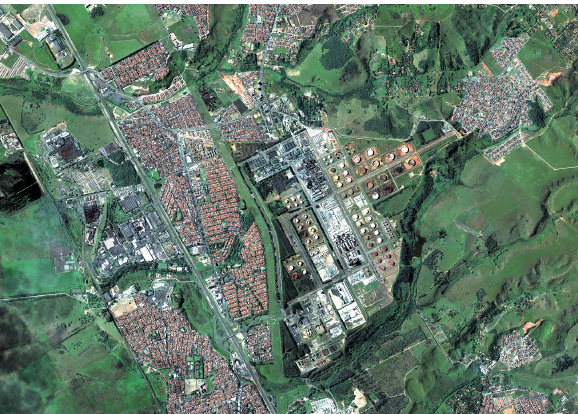
Figure 1. WorldView-2 image used in the experiments. (In this figure the image was rotated by 90